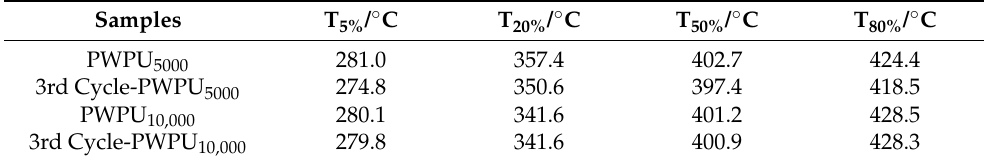
Figure 13. TGA curves of PWPU 5000 ( a ) and PWPU 10,000 ( b ) samples before and after three recycling processes. Table 4. Data of thermal